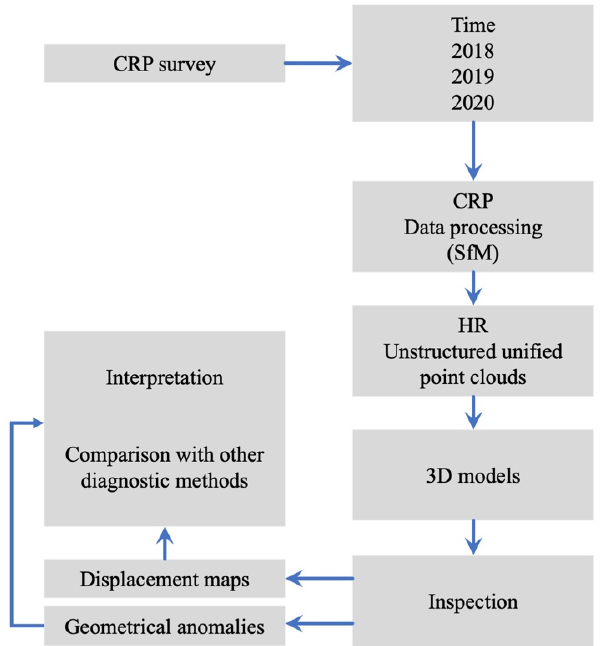
Figure 3. Workflow of the CRP data processing; CRP data are processed with Agisoft Metashape ® , JRC-3D Reconstructor ® , and Danielgm CloudCompare software.